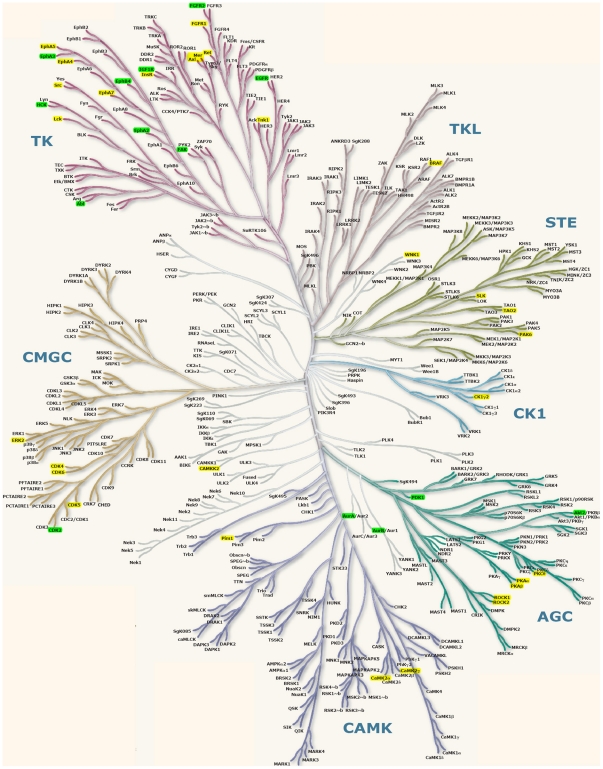
Distribution of predicted off-targets on the human kinome tree.Green represents off-targets with an SMAP p-value less than 1e-4. Yellow represents off-targets with an SMAP p-value less that than 1e-3 and greater than 1e-4.